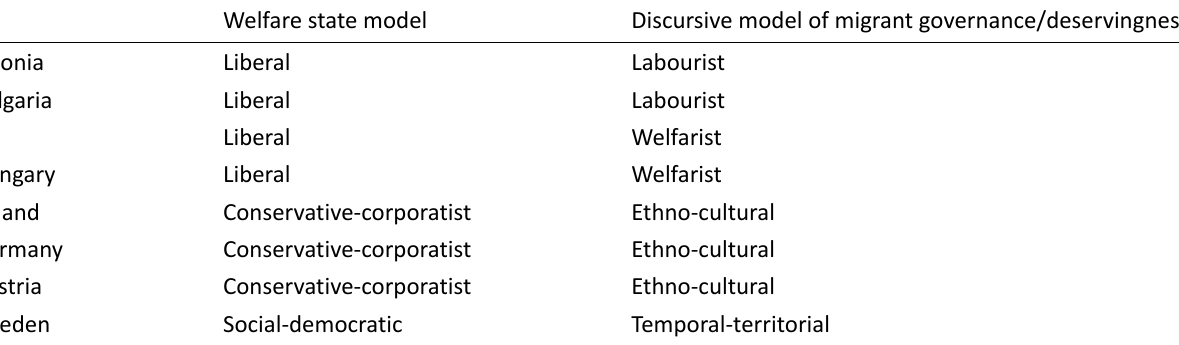
Table 1. Interrelations between welfare state models and the discourses on deservingness (based on expert